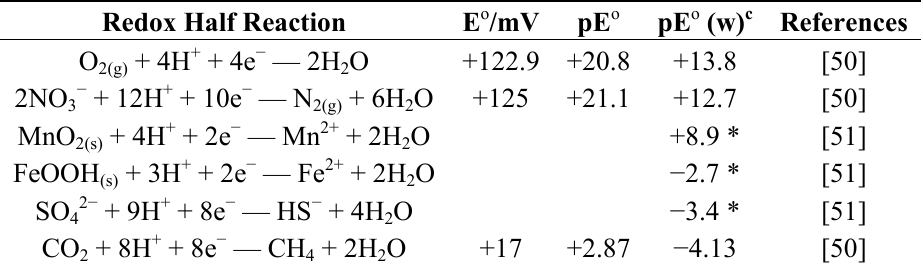
Table 1. Redox half reactions for common electron